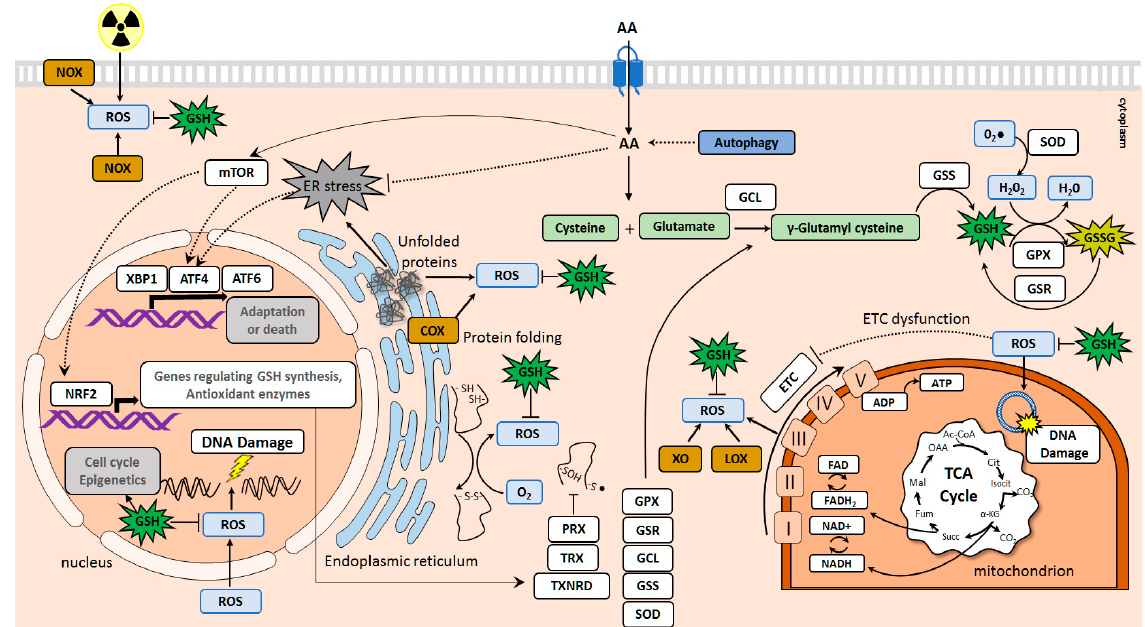
Figure 1. Amino acid transporters in the maintenance of redox homeostasis. The reactive oxygen species (ROS) are generated in the cells in different ways, including the electron transport chain (ETC) in mitochondria, oxidative protein folding in the endoplasmic reticulum (ER), and enzymatic reactions involving, e.g., cyclooxygenases (COX), lipoxygenases (LOX), xanthine oxidases (XO), and nicotinamide adenine dinucleotide phosphate (NADPH) oxidases (NOX). An increased ROS production contributes to the damaging of DNA, lipids, and proteins. Amino acid transporters regulate the redox homeostasis by driving glutathione (GSH) synthesis, inducing mammalian target of rapamycin (mTOR)-mediated antioxidant defense, and preventing endoplasmic reticulum (ER) stress. Autophagy also contributes to the maintenance of the intracellular free amino acid pool. GSH is synthesized in cytosol from Cys and Glu by glutamate-cysteine ligase (GCL) and glutathione synthetase (GSS). The reduced form of glutathione, GSH, is oxidized to glutathione disulfide (GSSG) by glutathione peroxidase (GPX) to neutralize hydrogen peroxide (H 2 0 2 ) and is reduced back to GSH by glutathione reductase (GSR). The mTOR mechanism of antioxidant defense includes activation of the nuclear factor-erythroid 2 -related factor 2 (NRF2), a master transcription factor. NRF2 regulates the expression of many genes involved in the GSH synthesis, including GCL , GSS , GPX , GSR, other genes involved in the regulation of ROS levels, such as superoxide dismutase ( SOD ) enzyme which converts superoxide (O 2• − ) to H 2 0 2 , genes encoding thiol-specific antioxidant proteins thioredoxin (TRX) and thioredoxin reductase (TXNRD) as well as peroxiredoxin (PRX). mTOR also triggers ATF4-mediated gene expression of the heterodimeric transmembrane amino acid transporters such as SLC7A5 ( LAT1 ), SLC3A2 ( CD98hc ), and SLC7A11 ( xCT ).